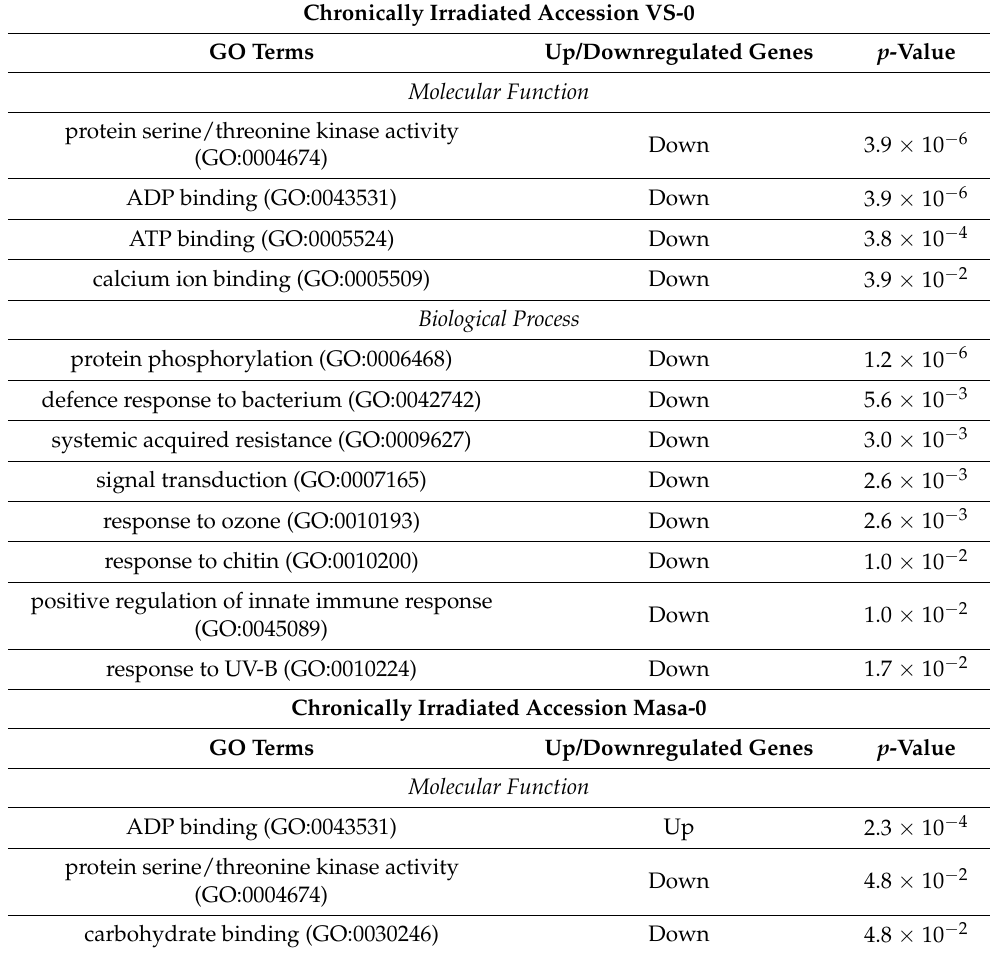
Table 3. Set of enriched GO terms in the chronically irradiated A. thaliana natural accessions VS-0 and Masa-0 in comparison with the reference accession